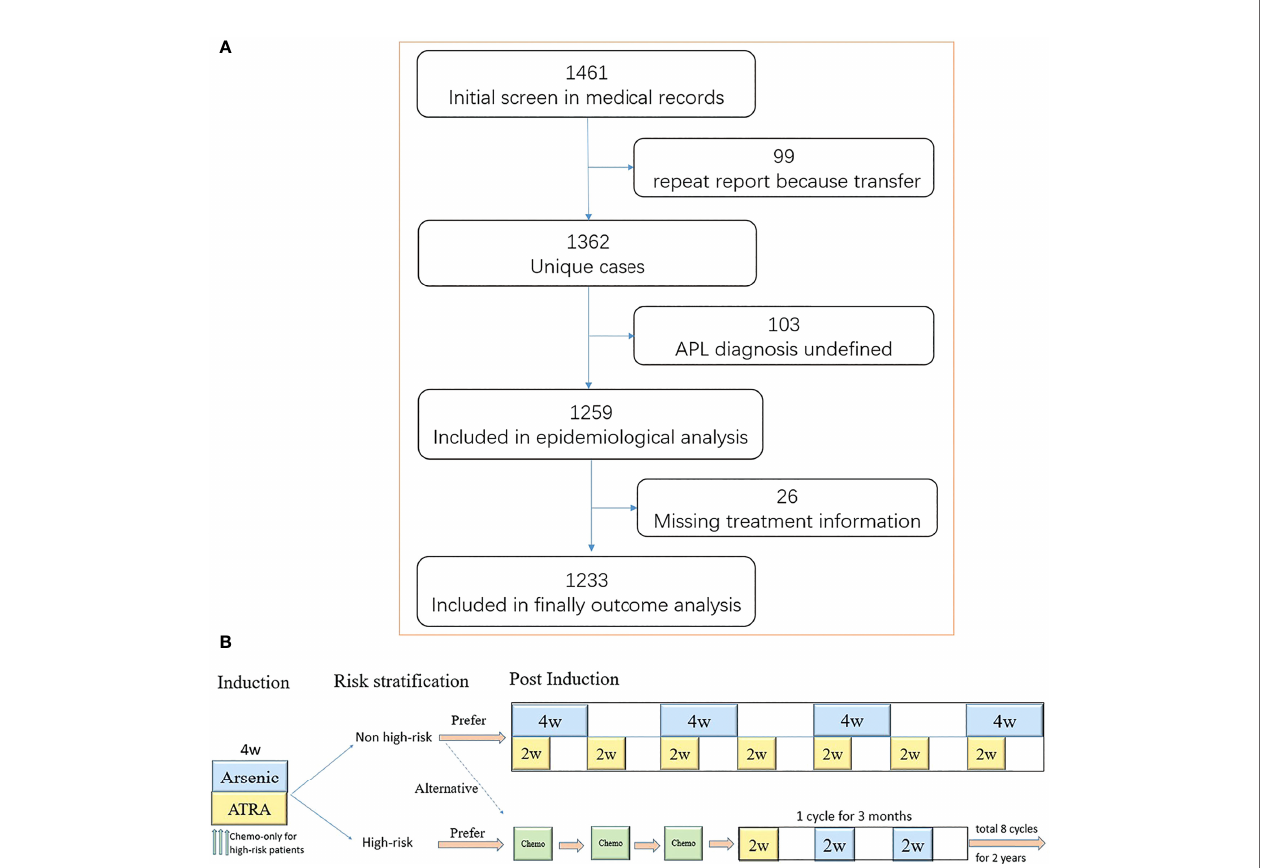
FIGURE 1 | The fl ow and treatment protocol recommended by guideline 2014. (A) Shown is the fl ow of screening, exclusion, and retention. A total of 99 patients transferred to at least two medical centers. Moreover, 103 patients did not have a de fi nitive diagnosis [11 patients did not perform bone marrow puncture examination, including four early deaths; four patients had a typical acute promyelocytic leukemia (APL) morphology, but the karyotype and molecular biology was negative; 88 patients had a typical APL morphology without karyotype and molecular biology results, including 15 early deaths]. The treatment information of 26 patients was missing. (B) Induction therapy lasts for at least 4 weeks until complete remission is achieved. The chemotherapy drugs included anthracycline, cytarabine, and homoharringtonine. One single agent was usually used as induction chemotherapy